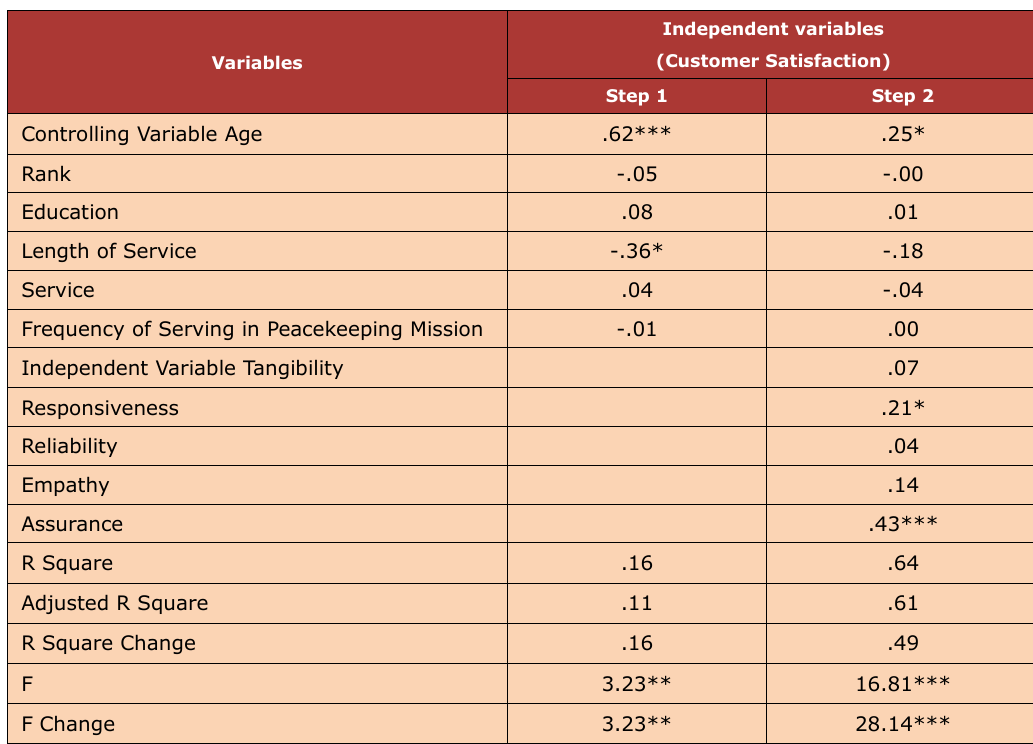
Table 5. Results for Multiple Regression